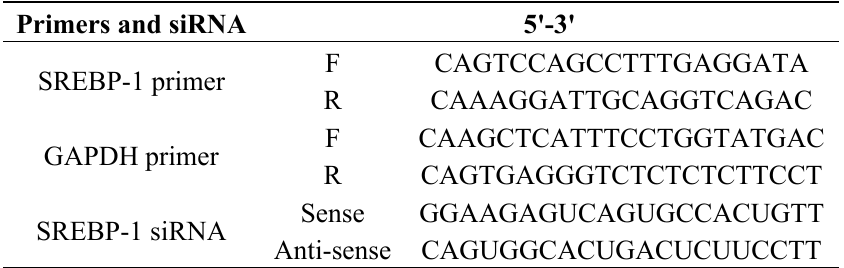
Table 3. Primers for real-time PCR and SREBP-1 siRNA